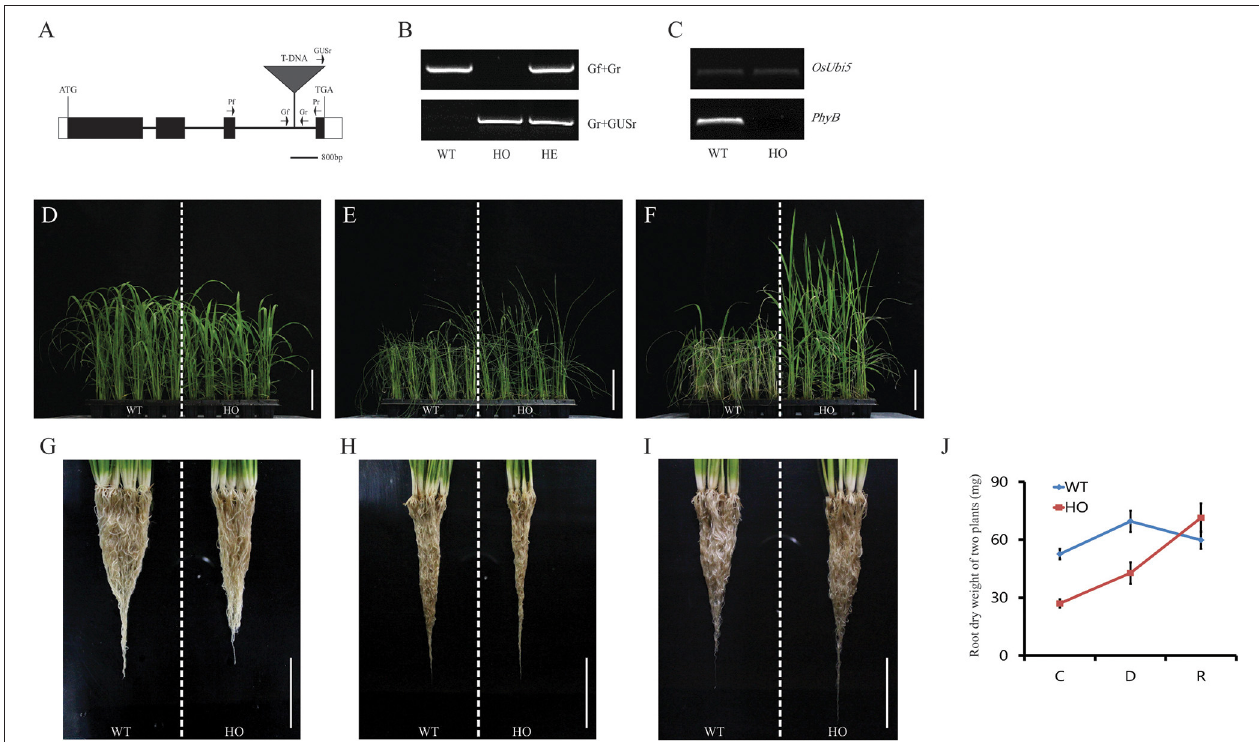
FIGURE 8 | Drought-stress response mediated by PhyB using T-DNA insertional mutant. Schematic diagram for T-DNA insertion site in PhyB of Line 4A-02226 is shown (A) . Black boxes represent exons; white boxes, UTR; lines between boxes, introns; gray triangle, T-DNA insertion; small arrows, gene-specific primers for qRT-PCR analysis and genotyping of tagged gene. ATG and TGA indicate start and stop codons. Scale bar = 800 bp. Genotyping was performed for phyB mutant line (B) . Genotyping experiment identified homozygous progenies with T-DNA in PhyB . WT, wild-type segregants of T-DNA insertional line in PhyB ; HO, homozygote; HE, heterozygote. Expression of PhyB was significantly suppressed in mutant (C) . OsUBI5 (LOC_Os01g22490) was used as internal control. phyB homozygous progenies with T-DNA insertion demonstrated drought-tolerant phenotype. phyB and wild-type segregants grown in plastic pots for 4 weeks was exposed to water deficiency for 3 d. Photos were taken 7 d after re-watering (D–F) . Scale bar = 10 cm. (G–J) shows the respective roots and dry weight. Scale bar = 5 cm. N = 3 for (D–I) ; n = 100 for (J) . ( Figure 9B ). Measurement of APX enzyme activity between phyb mutants and wild type segregants demonstrates that phyb mutants have the better performance of APX activity at drought stress for 3 d than that of wild type. In addition, the CAT activity of the phyb mutants was consistently higher than that of WT, although it decreased during drought stress rather than normal condition ( Figure 9C ). Therefore, we estimate that phyb mutant might retain the tolerance to drought stress by effective ROS scavenging in root besides controlling stomatal density in